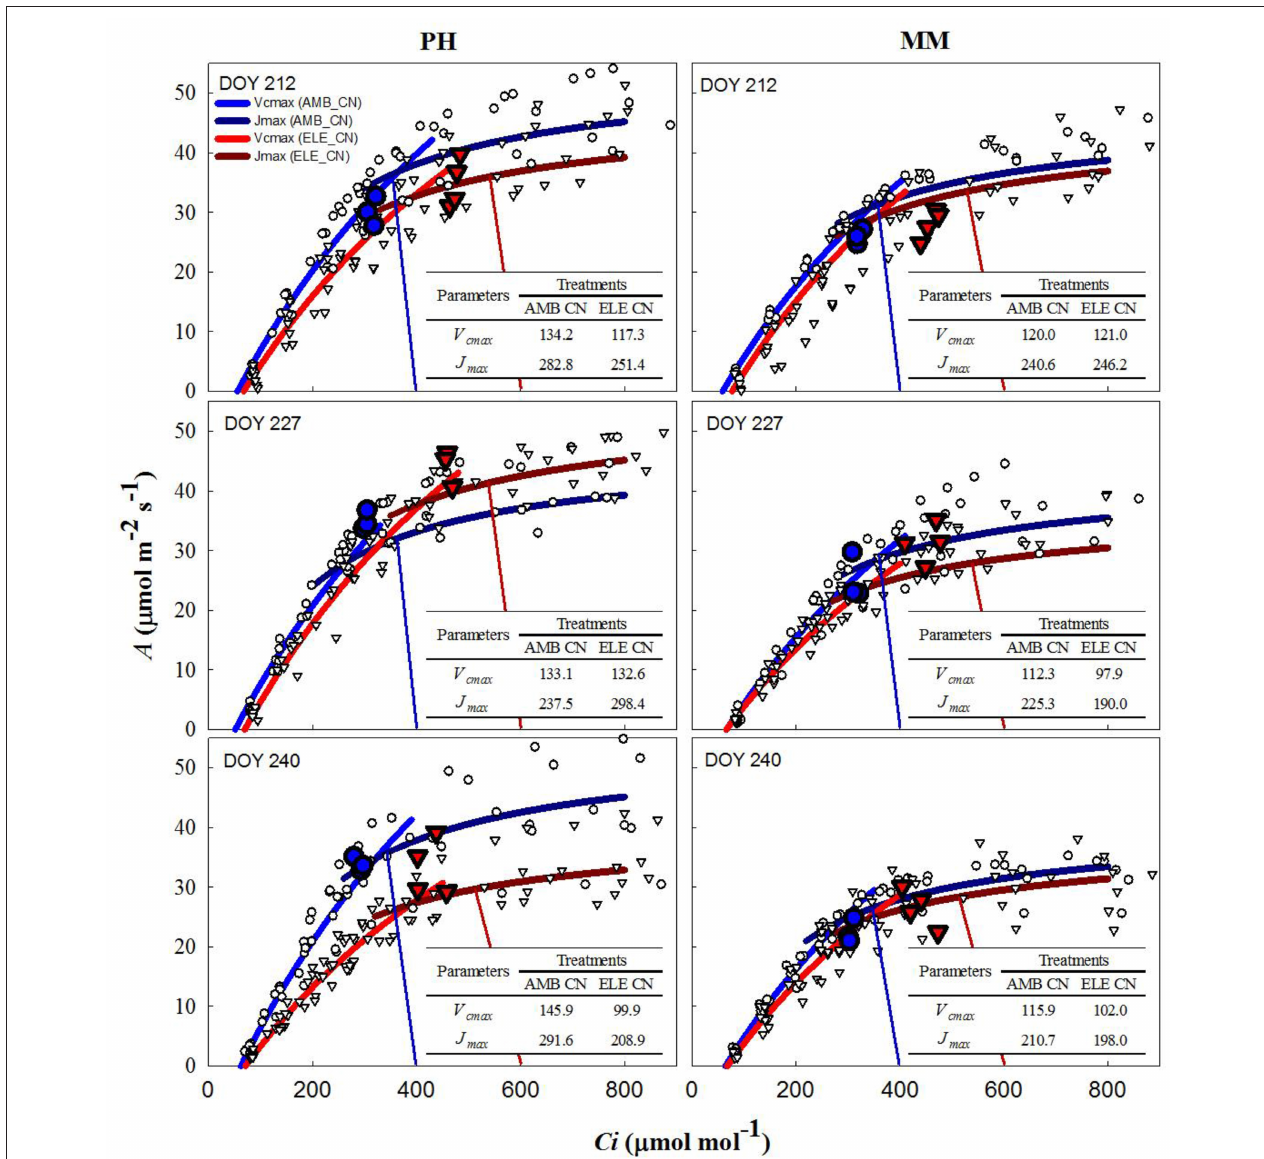
FIGURE 2 | Fitted responses of A to Ci curves. Inserted tables indicated the daily average V cmax ( µ mol m − 2 s − 1 ) and J max ( µ mol m − 2 s − 1 ) for the control N treatments in PH and MM (see also Table S4). Ambient [CO 2 ] treatments are represented by blue lines while the elevated [CO 2 ] treatments by red lines. The data to which the lines are fit, are shown by white symbols (circles are ambient [CO 2 ] and triangles are elevated [CO 2 ] treatments). The blue and red vertical lines represent the supply functions (1/- g s ) for the ambient and elevated growth [CO 2 ], respectively, intercepting the fitted A/C i at the operating point. The blue (AMB) and red (ELE) large symbols are the treatment means for the midday photosynthesis that were taken the day before of the A/C i curves. The photosynthetically active radiation (PAR) and air temperature at midday, when these measurements were made, for DOY 211, 226, and 239 were: 1,800, 2,000, and 1,600 µ mol m − 2 s − 1 and 28, 28, and 22.5 ◦ C,